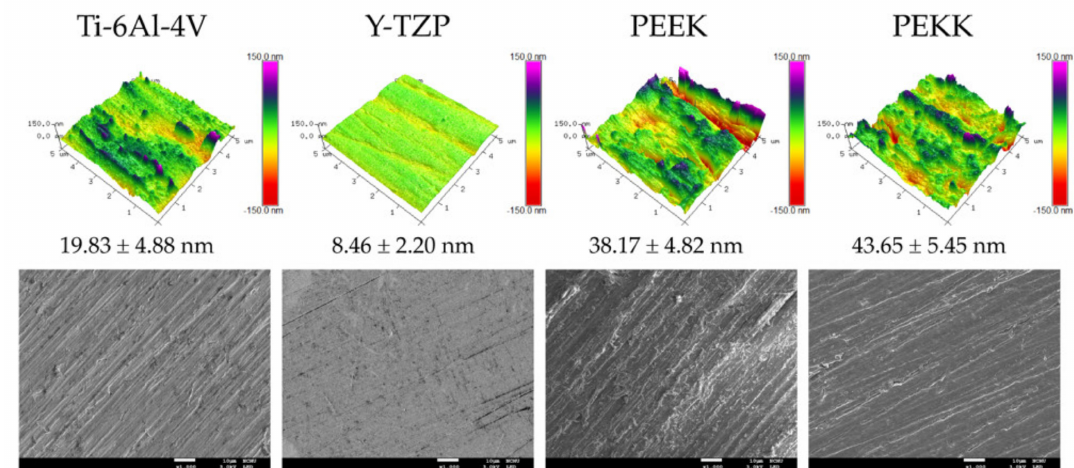
Figure 1. First row: 5 × 5 µ m 2 AFM images and the submicron surface roughness (Ra) taken from the flattened surface of each testing material. The surface topography is presented as different color ranges, from +150 nm (purple) to − 150 nm (red), and the Ra values are shown under each image (mean ± standard deviation (SD), n = 3). Second row: FE-SEM microphotographs of surface morphologies. The scale bars are 10 µ m (original magnification ×